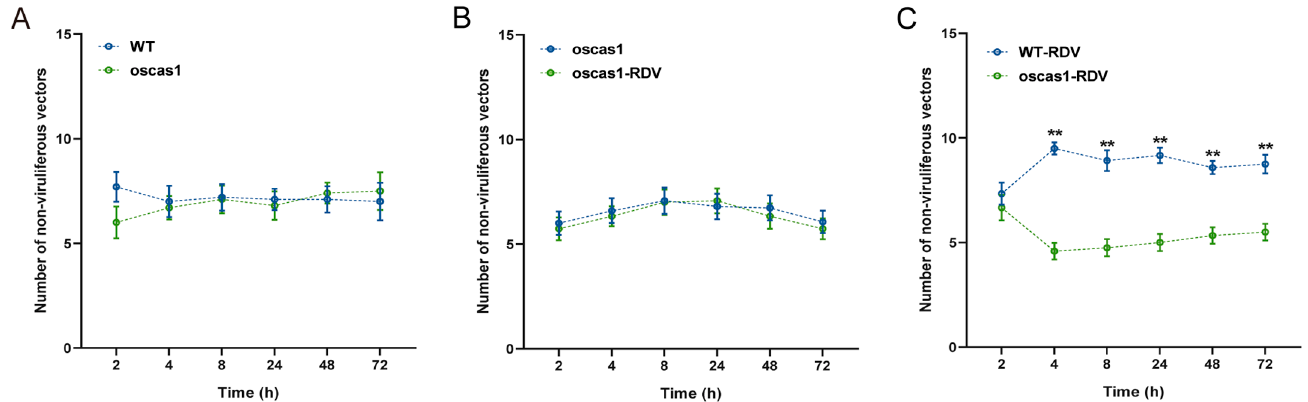
Figure 4. Feeding preferences of non-viruliferous N. virescens between WT and oscas1 rice plants ( A ); oscas1 and oscas1-RDV rice plants ( B ); and WT-RDV and oscas1-RDV rice plants ( C ). RDV, rice dwarf virus; WT, wild type (Minghui63, MH63) (RDV-free); WT-RDV, MH63-RDV (RDV-infected); oscas1, mutant rice plant (RDV-free); oscas1-RDV, mutant rice plant (RDV-infected). All feeding choice assays were performed with fifteen biological replicates, each of fifteen newly emerged adults. The statistical differences between the two treatments in the same column were indicated by asterisks (** p < 0.01, Wilcoxon’s signed-ranks tests). Data are mean ± standard